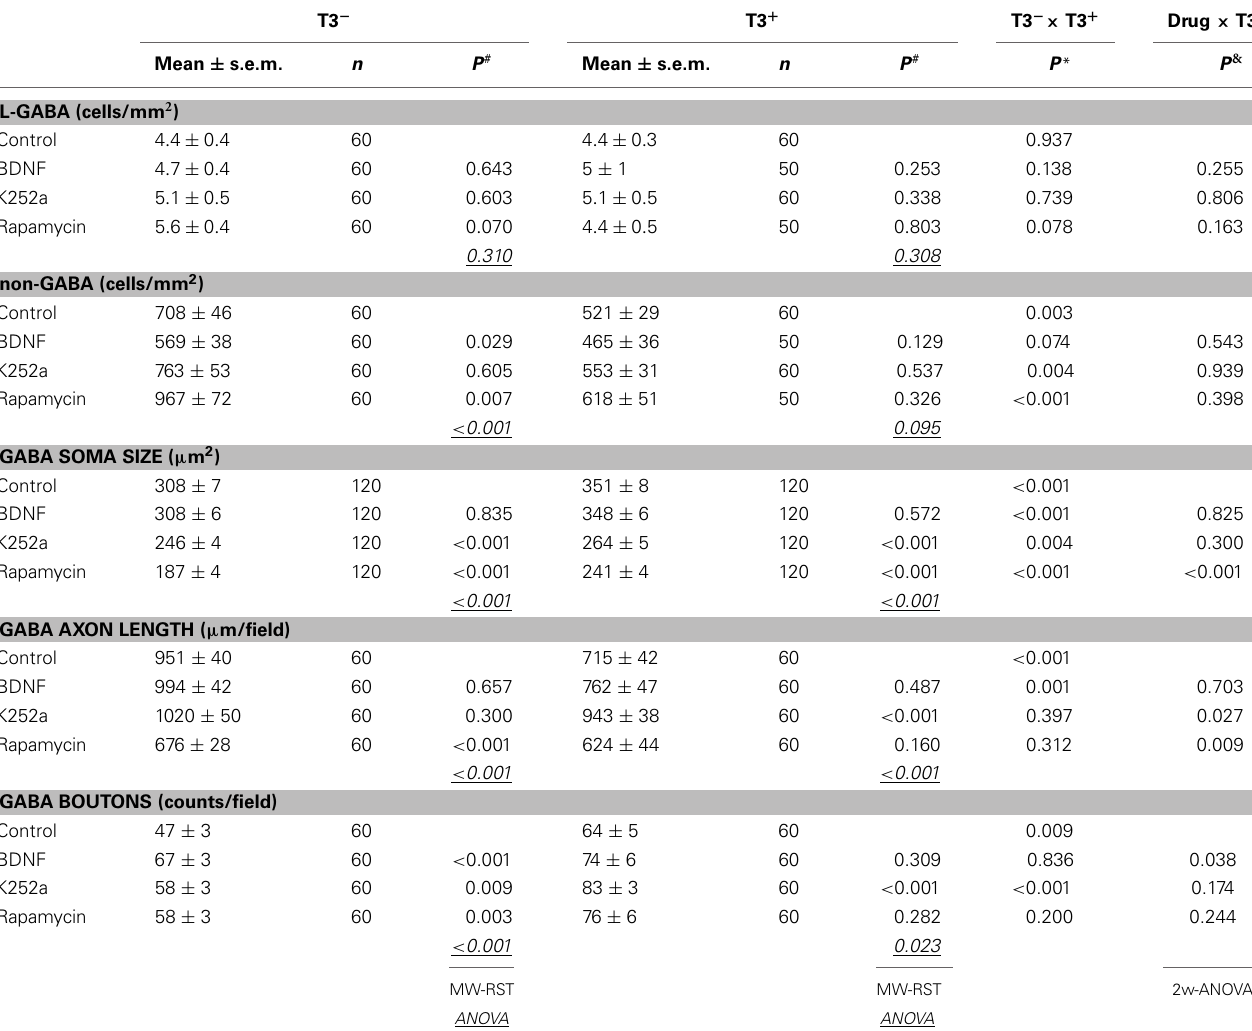
Table 5 | Summary of neuronal population quantification, L-GABAergic cell size measurements, and of the GABAergic axon parameters.